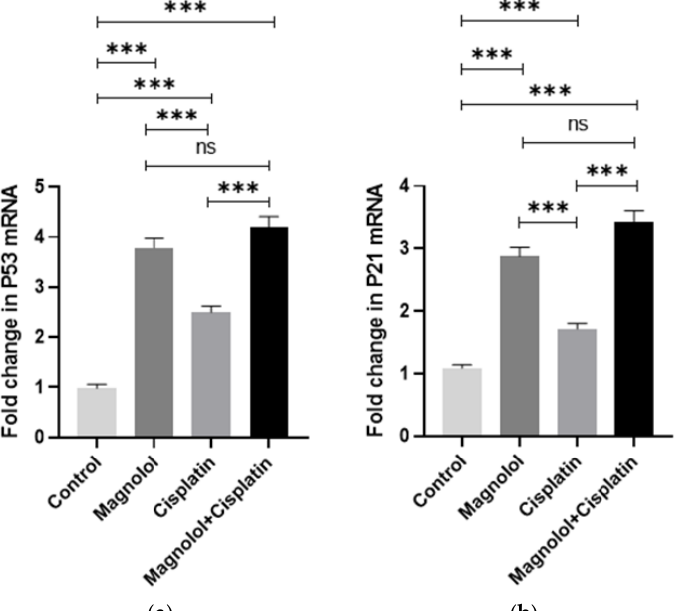
Figure 5 . Changes in cell cycle regulator genes following magnolol and/or cisplatin therapy. ( a ) All treated groups showed significantly elevated levels of p53 compared to the control group. The group that received a combination of magnolol and cisplatin had the maximum expression of p53 . ( b ) All treated groups showed significantly elevated levels of p21 compared to the control group. The group that received a combination of magnolol and cisplatin had the maximum expression of p21 . β -actin was used as the reference gene for normalizing the relative quantitative expression of target genes. All experiments were performed in triplicate. ns: not significant. *** p < 0.001. 3.6. The Effects of Magnolol and/or Cisplatin on the Expression of Extracellular Matrix